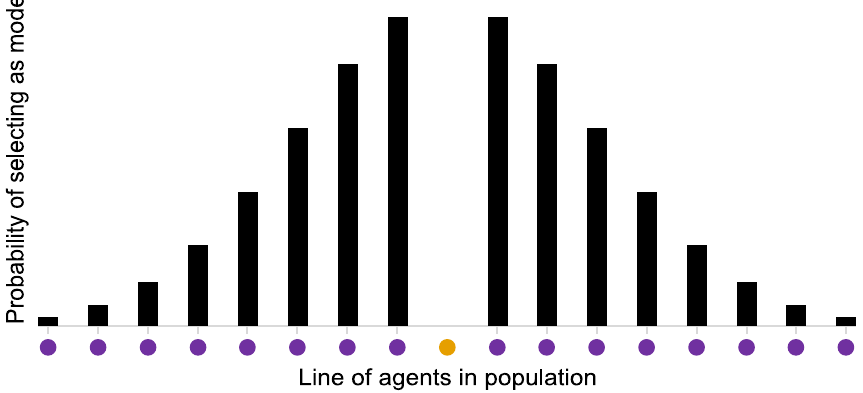
Figure 2. Diagram showing how neighbourhood structure was imposed by selecting each agent’s (in orange) models from the neighbouring agents (in purple) using Gaussian